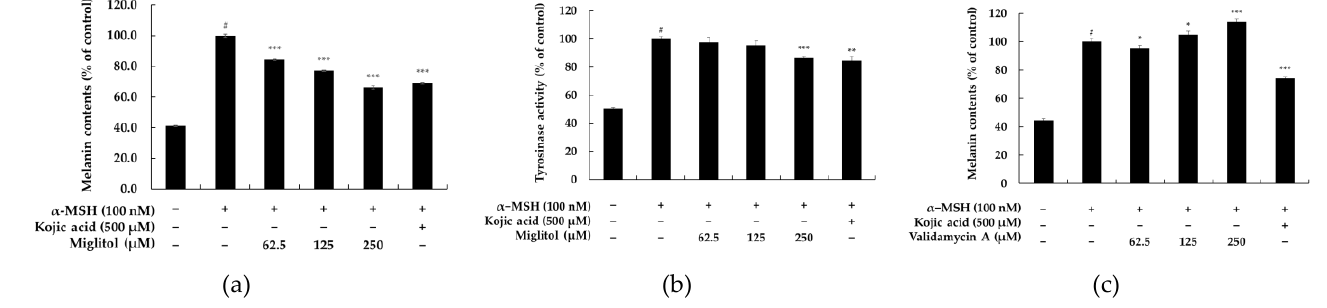
Figure 3. Effects of α -glucosidase inhibitors on the melanin content and tyrosinase activity in α -MSH-stimulated B16F10 cells. Cells were plated in a 60 mm cell culture dish (8.0 × 10 4 cells/dish) and incubated for 24 h, followed by ( a , b ) miglitol (62.5 – 250 µM) and ( c ) validamycin A (62.5 – 250 µM) pre- treatment for 1 h and subsequent treatment with α -melanocyte-stimulating hormone ( α -MSH, 100 nM) for 72 h. The cells were then harvested and assayed. α -MSH was used as the negative control, and kojic acid (500 µM) was used as the positive control. Melanin content and tyrosinase activity data are presented as the mean ± standard deviation (SD) of at least three inde- pendent experiments ( n = 3). # p < 0.001 compared to the non-treatment group; * p < 0.05, ** p < 0.01, and *** p < 0.001 vs. the α -MSH only group.